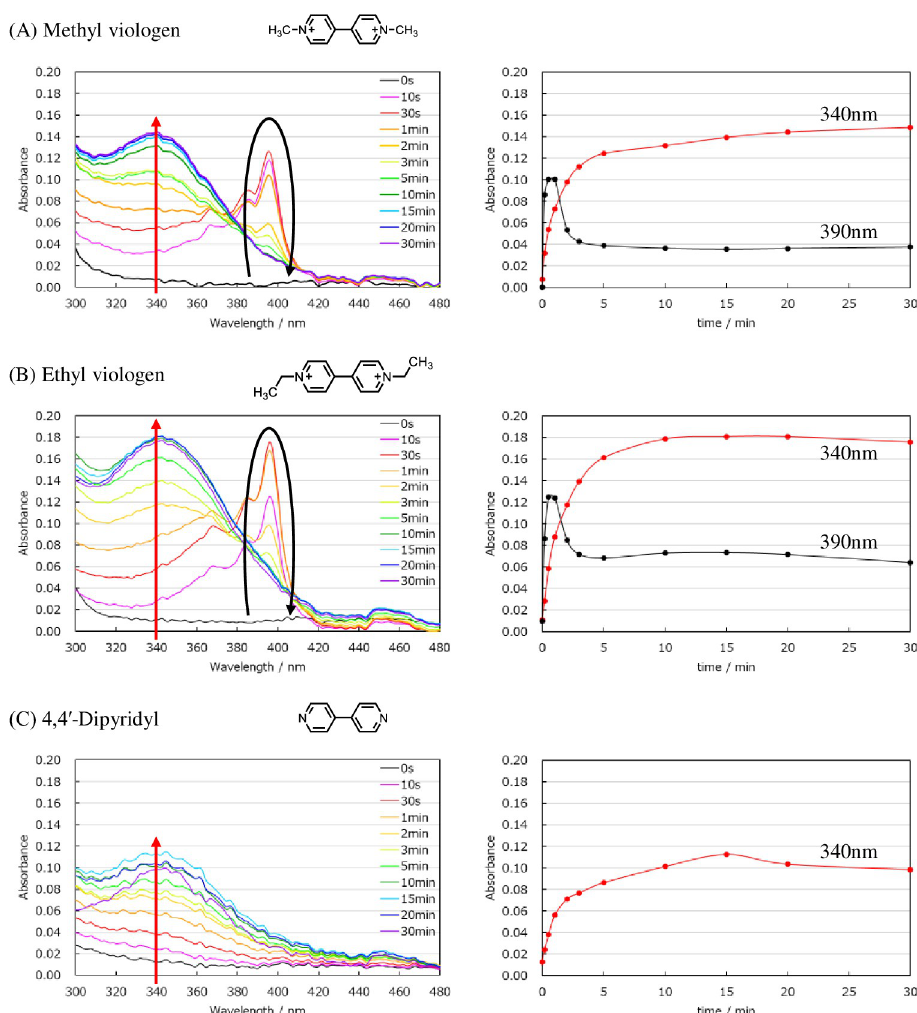
Fig 4. Absorbance measured while applying a voltage (-1.05 V) of a mediator solution (0.25 mM) containing 1 mM NADP. On the left is the absorption spectrum from 300 nm to 480 nm. On the right is a plot of absorbance at 340 nm and 390 nm for each hour. (A) Methyl viologen, (B) Ethyl viologen, (C) 4,4 0 -Dipyridyl. These experiments were repeated three times with similar results.